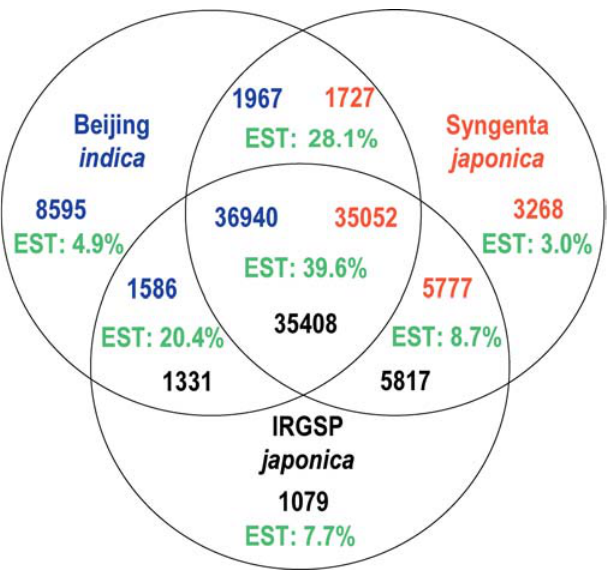
Figure 3. Overlapping FGENESH Predictions in All Three Rice Assemblies Two predictions are shared when 50% of their coding regions can be aligned. Because of imprecision in the predictions and overlap criteria, we get slightly different numbers for each assembly, and these are encoded through multiple color-coded numbers in the Venn diagram. EST confirmation requires 100 bp of exact match. Unlike the genes, we do not bother to show a different number for each assembly, because they are very similar. DOI: